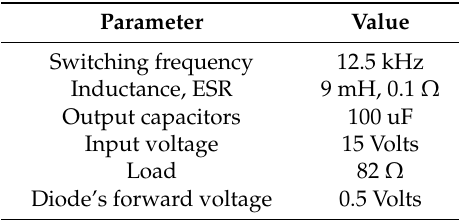
Figure 9. Block-diagram of the dSPACE DS1104 controller board. Table 2. TLBDC parameters.